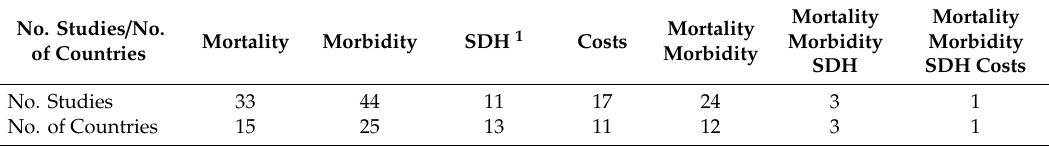
Table 6. No. of studies and countries by